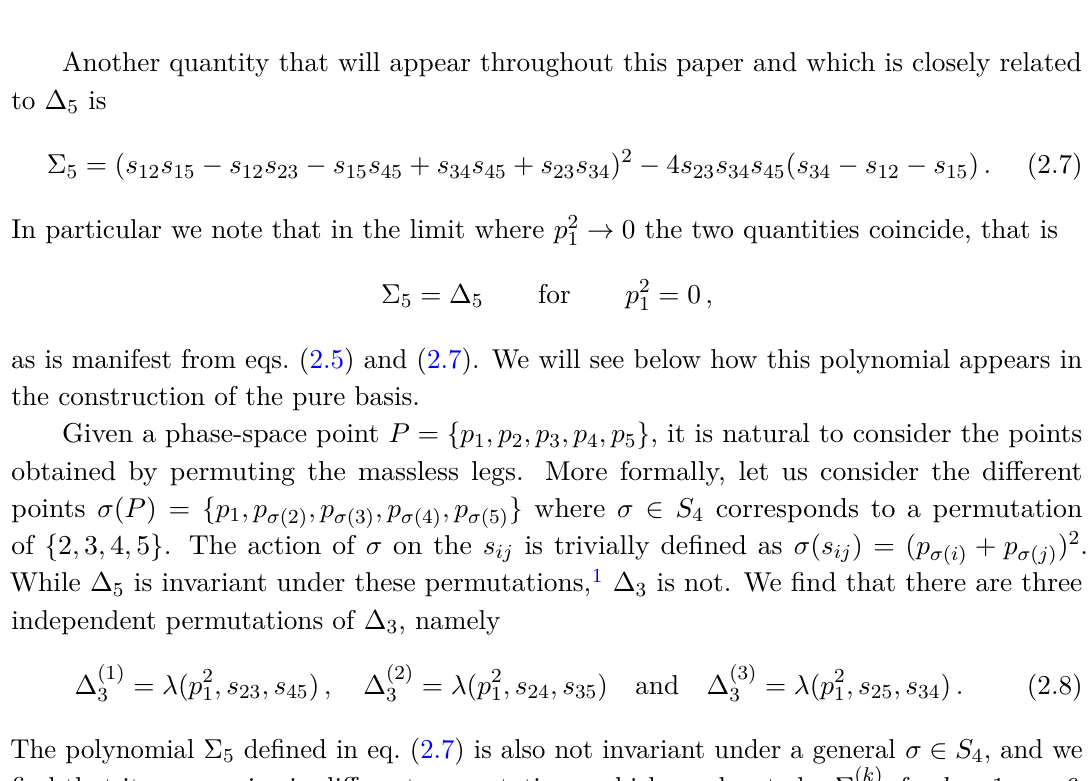
Figure 1. Two-loop five-point one-mass non-planar hexa-box topologies. The thick external line with label 1 denotes the massive external